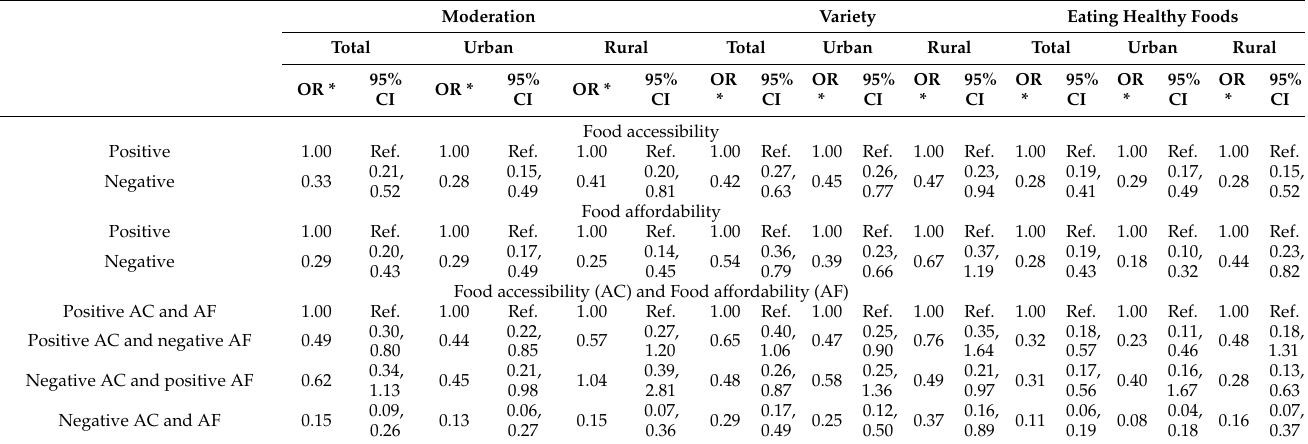
Table 6. The effect of perceived food environment on healthy eating behaviors by region. Moderation Variety Eating Healthy Foods Total Urban Rural Total Urban Rural Total Urban